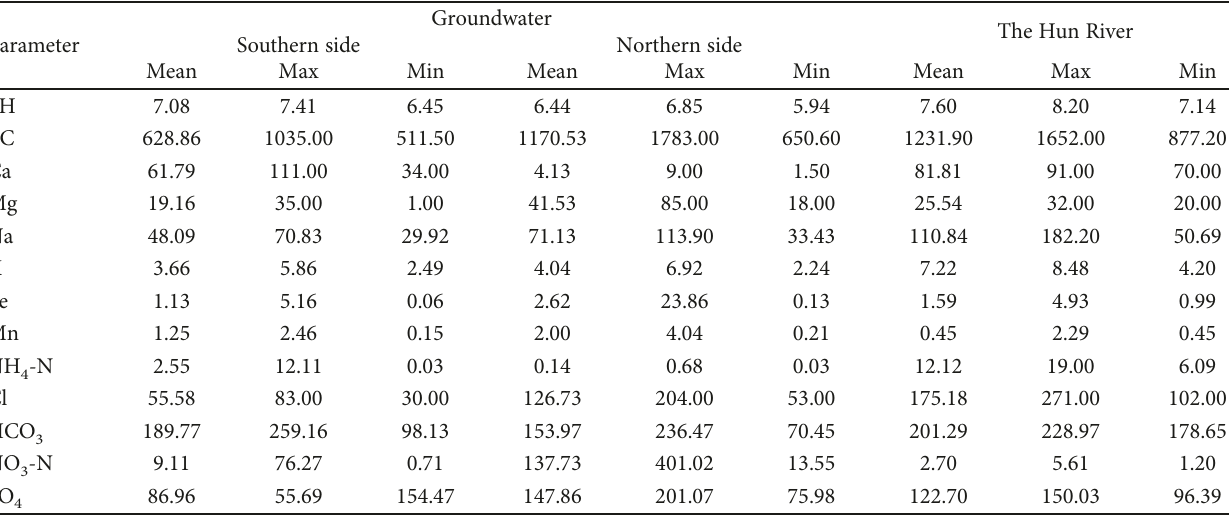
Table 2: Statistical summary of hydrochemical data in the Shenyang areas, March 2011. All units are in mg · L − 1 , except for electrical conductivity (EC, μ S · cm − 1 ).